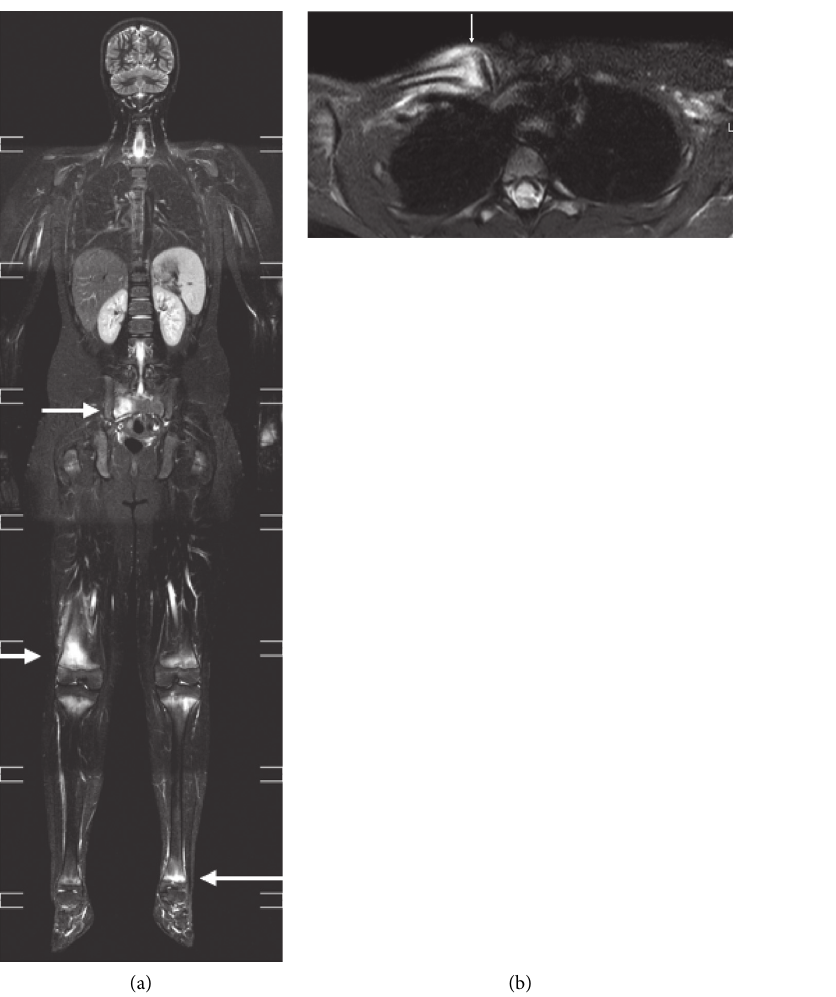
Figure 15: CRMO. Coronal whole-body MRI of an 8-year-old boy (a) with CRMO initially presenting with right knee pain. Note the multifocal involvement which included both knees, left ankle, and the sacrum (arrow). Axial STIR (b) of a different CRMO patient aged 7, with classic involvement of right medial clavicle with associated hyperostosis (arrow).